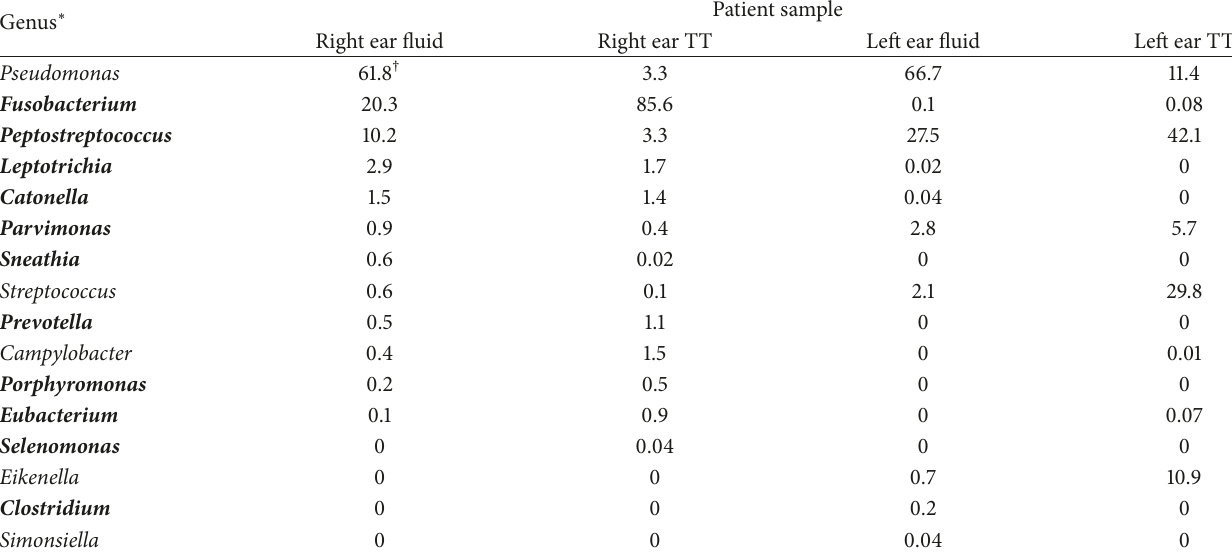
Figure 2: Distribution of major bacterial genera found within biofilms on the TT by deep parallel pyrosequencing. Numbers indicate the percentage of each genus present on the TT from (a) right ear and (b) left ear. Pseudomonas and Streptococcus are facultative anaerobes; Fusobacterium, Peptostreptococcus, and Parvimonas are obligate anaerobes; Eikenella is a microaerophile (preferring 10% oxygen, 10% carbon dioxide). “Other bacteria” represent genera present at less than 2.5% each. The identities and relative abundance of these organisms are provided in Table 2. Table 2: Relative abundance of genera discovered by pyrosequencing within the ear